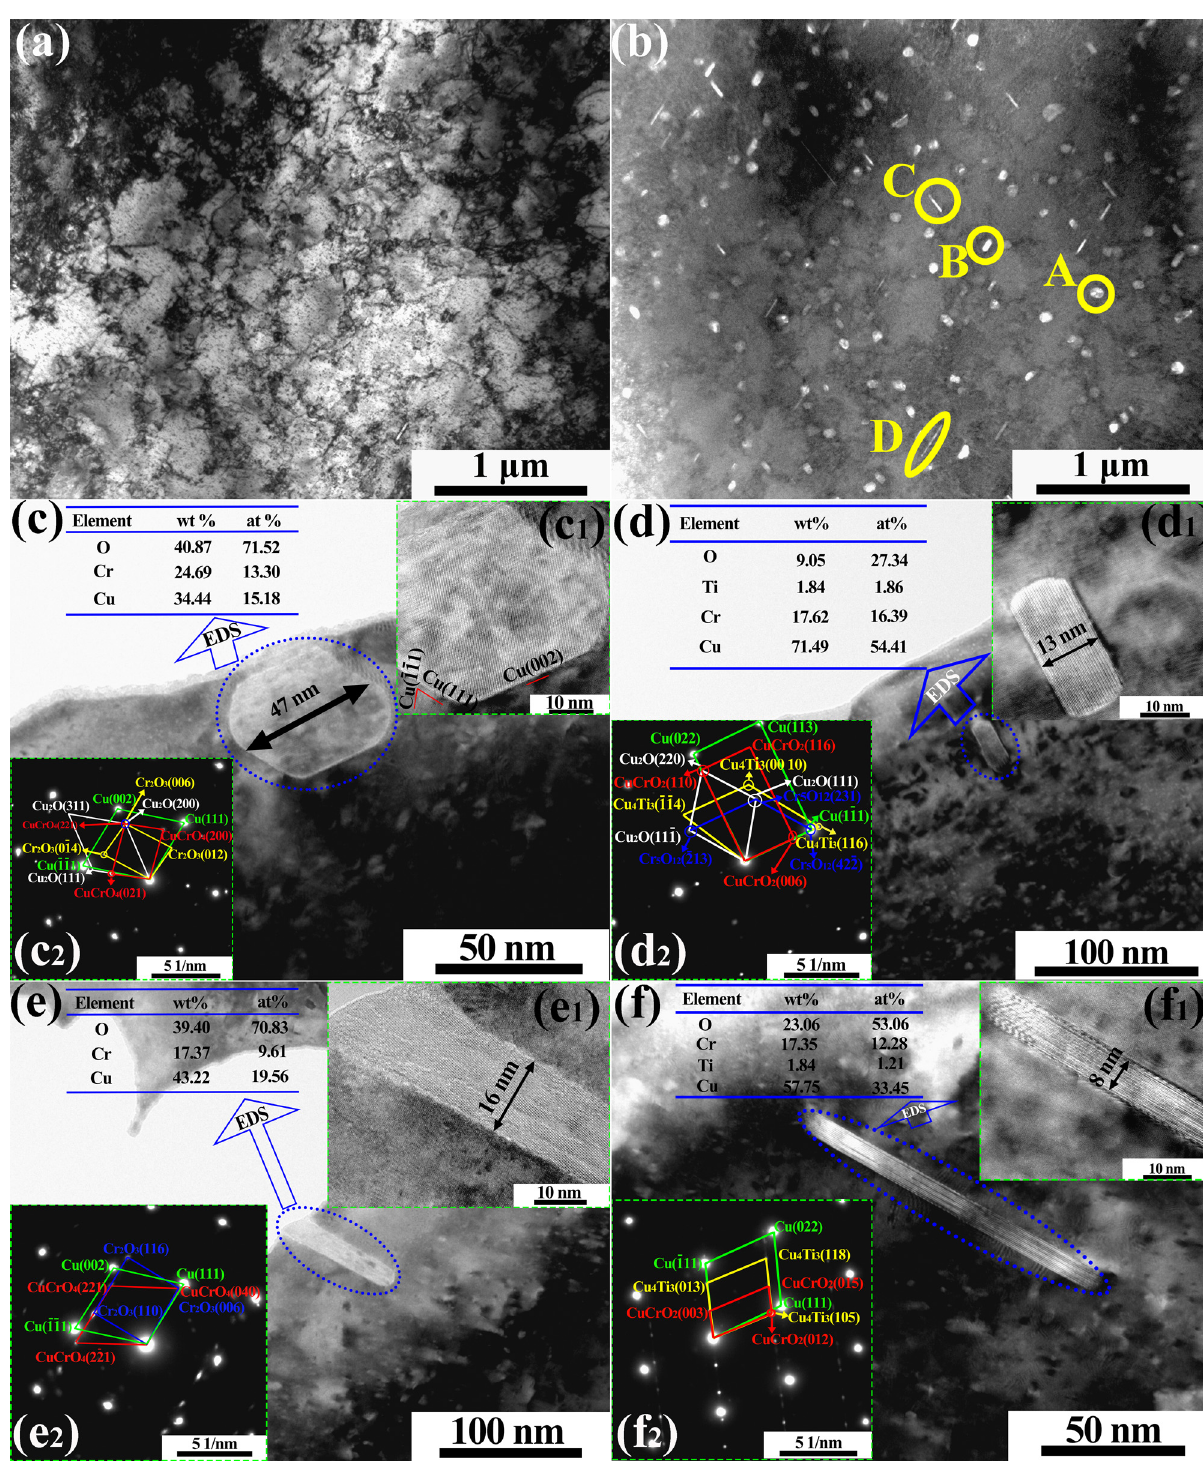
Figure 8: TEM images of Cu – Cr – Ti alloy after ITOX treatment: ( a ) bright fi eld image; ( b ) dark fi eld image; ( c, d, e and f ) the enlarged images; ( c ) , ( d ) , ( e ) and ( f ) high resolution TEM images inset; ( c 1 1 1 1